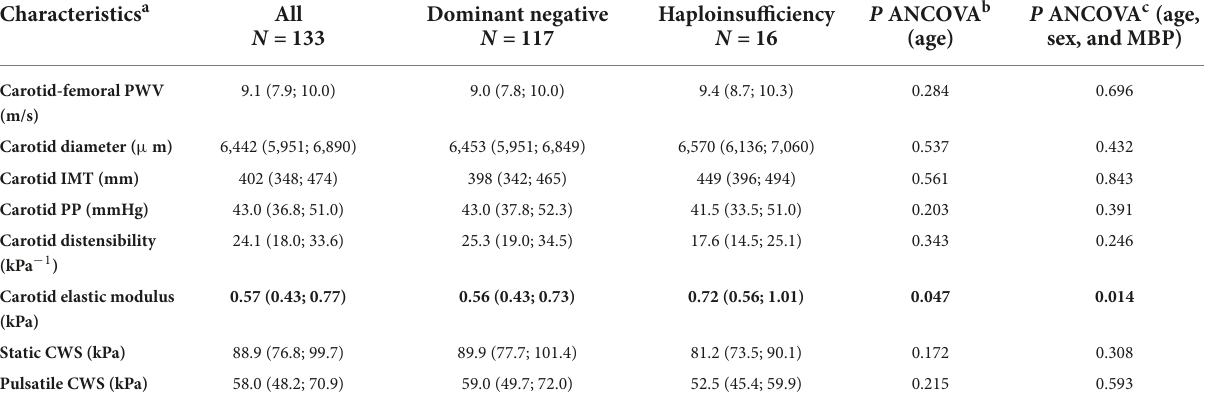
TABLE 2 Vascular function characteristics in N = 133 vEDS patients according to the type of COL3A1 variants. Characteristics